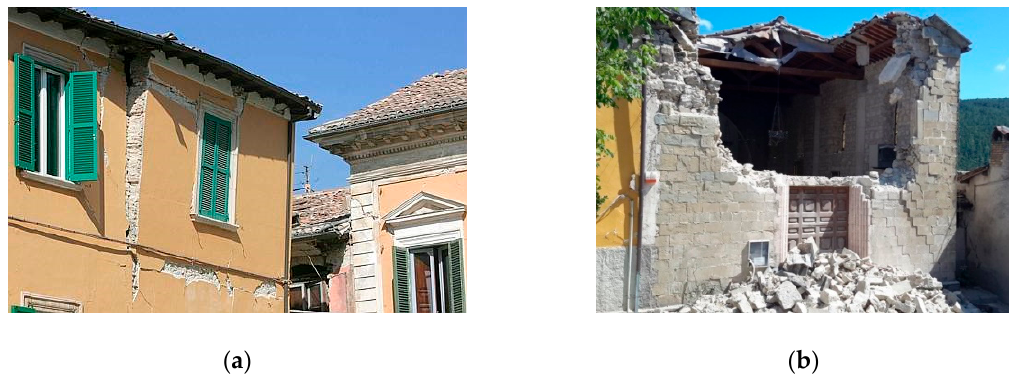
Figure 27. In seismic prone areas, wooden floors may prevent the out-of-plane mechanism of external walls (overturning). To facilitate this function, the wooden floors should be stiff enough (in-plane stiffness) and effectively connected to the walls to transfer the seismic load to the walls parallel to the seismic